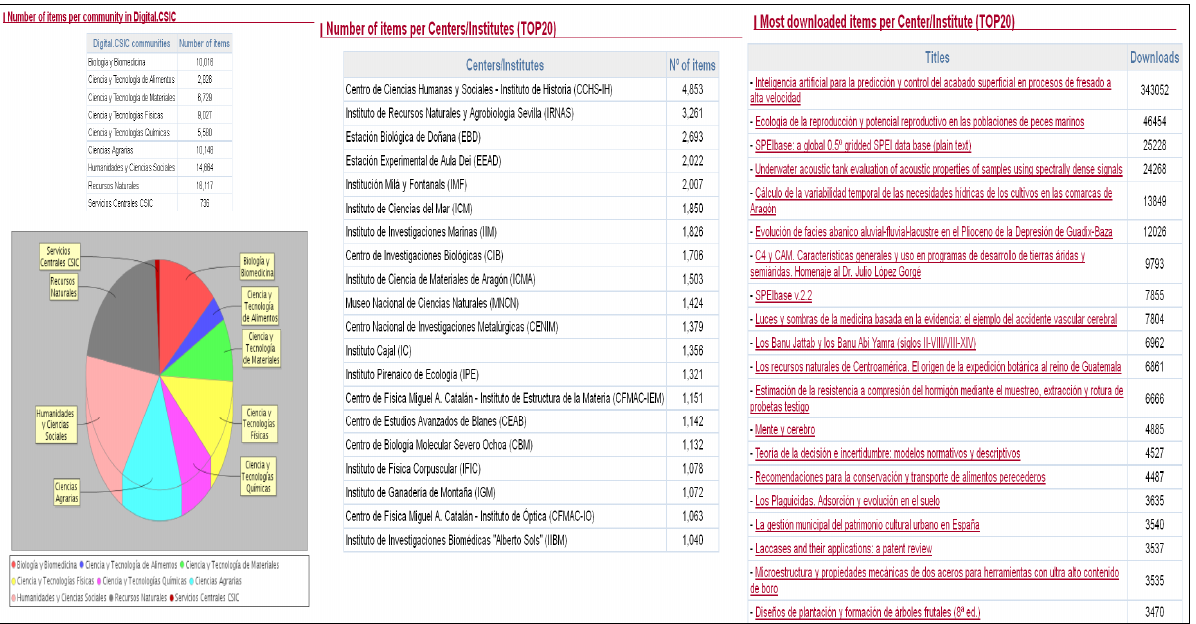
Figure 1. From left to right: Content distribution across all CSIC scientific areas; ranking of CSIC institutes with highest volume of items (totals), and 20 most downloaded items in 2013. Source: DIGITAL.CSIC general